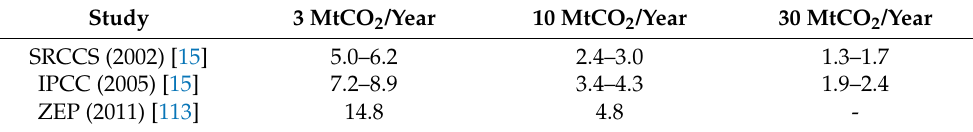
Table 12. Transport costs for offshore pipelines at three diverse capacities (adapted from [35]).